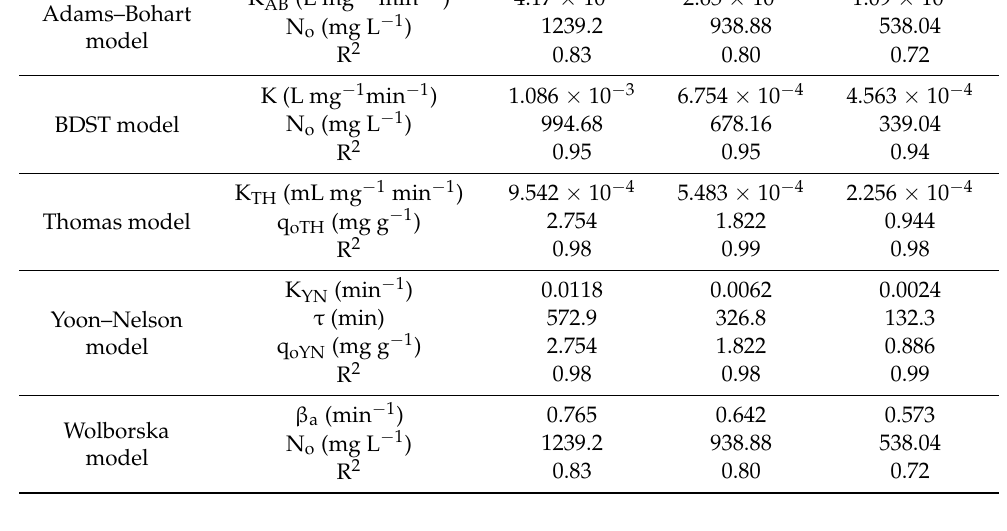
Table 5. Column characteristic parameters obtained at various runs for the decolorization of CR by sodium silicate gel-immobilized NNLP adsorbent. Immobilized NNLP Adsorbent